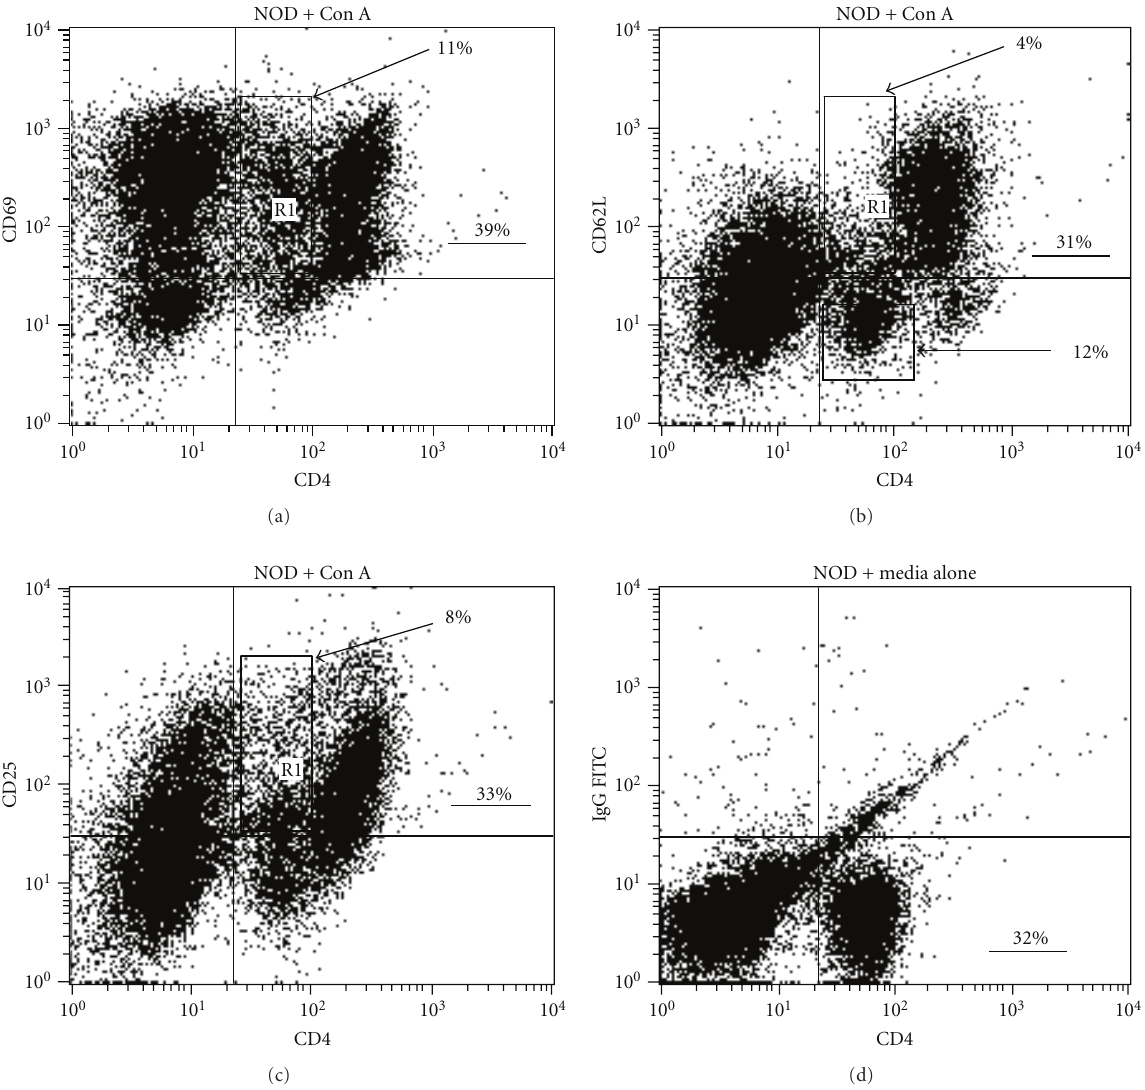
Figure 5: The “CD4lo” T cells that persist among NOD Con A blasts are antigen-experienced. NOD spleen cells were cultured for 72hrs with Con A, stained with anti-CD4-PE and anti-CD69-FITC (a), anti-CD62L-FITC (b), or anti-CD25-FITC (c), and analyzed by flow cytometry (20,000 events were collected for each analysis). The selected regions (boxes) in the dot plots mark the “CD4lo” population, and the numbers indicate their percentage in the total population. The underlined numbers indicated the percentage of CD4 + cells in the total population. (d) Freshly isolated NOD splenocytes were stained with anti-CD4-PE and IgG-FITC for comparison to baseline CD4 expression on na¨ıve T cells. These data are representative of two